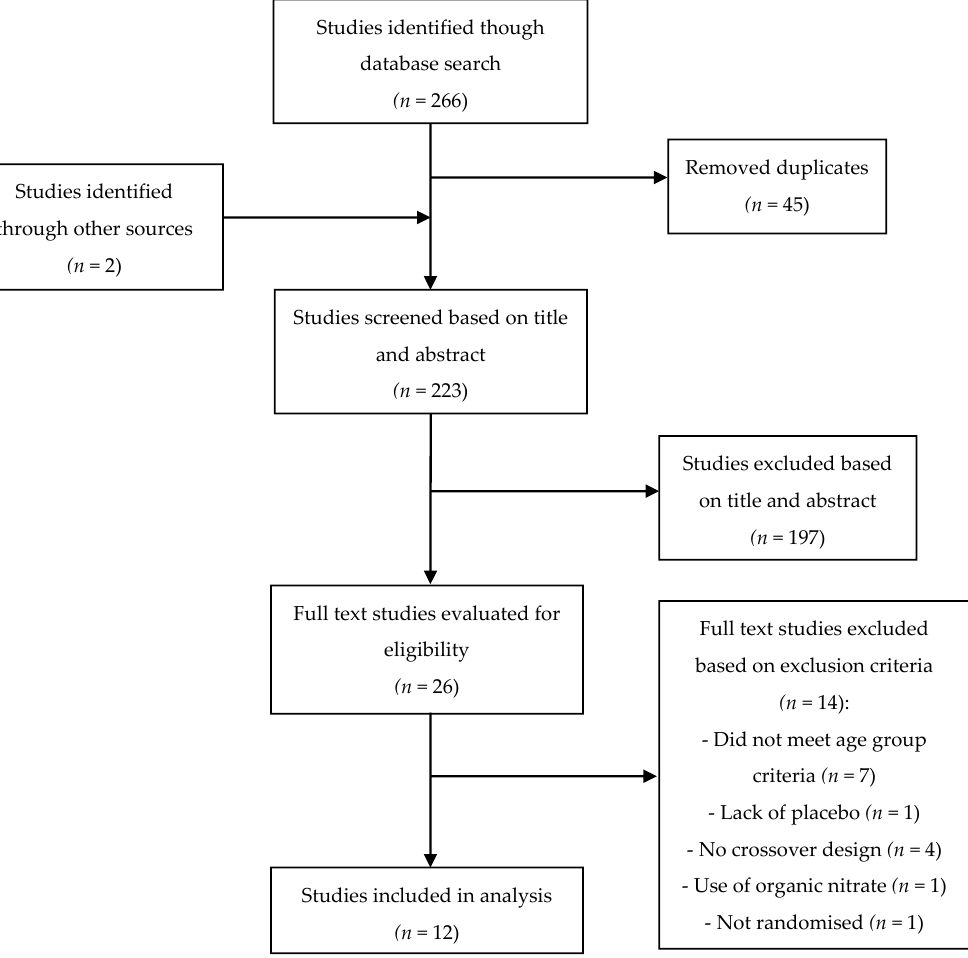
Figure 1. Flowchart showing study selection procedure and results.